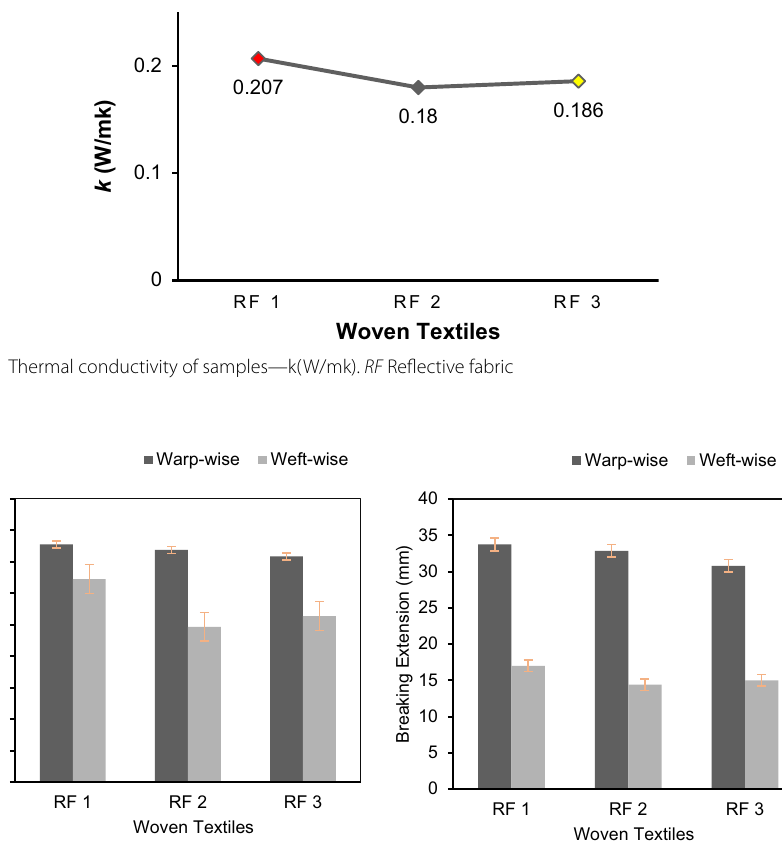
Fig. 15 Tensile strength of samples. RF means reflective fabric, RF 1 has a weave structure 1/3 twill and ¼ broken twill; RF 2 has ¼ broken twill and ¼ satin, move 3; and RF 3 has ¼ satin, move 2 and ½